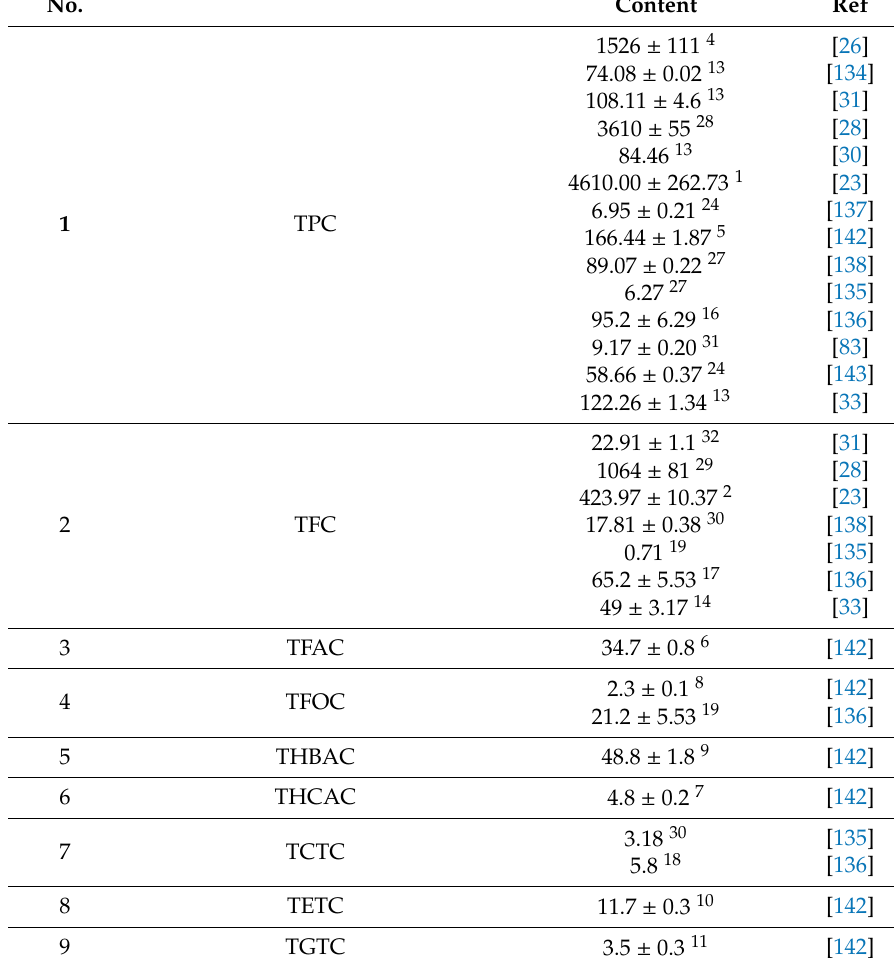
The obtained values for total phenolic content (TPC), total flavonoid content (TFC), total flavanol content (TFAC), total flavonol content (TFOC), total hydroxybenzoic acid content (THBAC), total hydroxycinnamic acid content (THCAC), total condensed tannin content (TCTC), total ellagitannin content (TETC), total gallotannin content (TGTC), the radical scavenging activity against